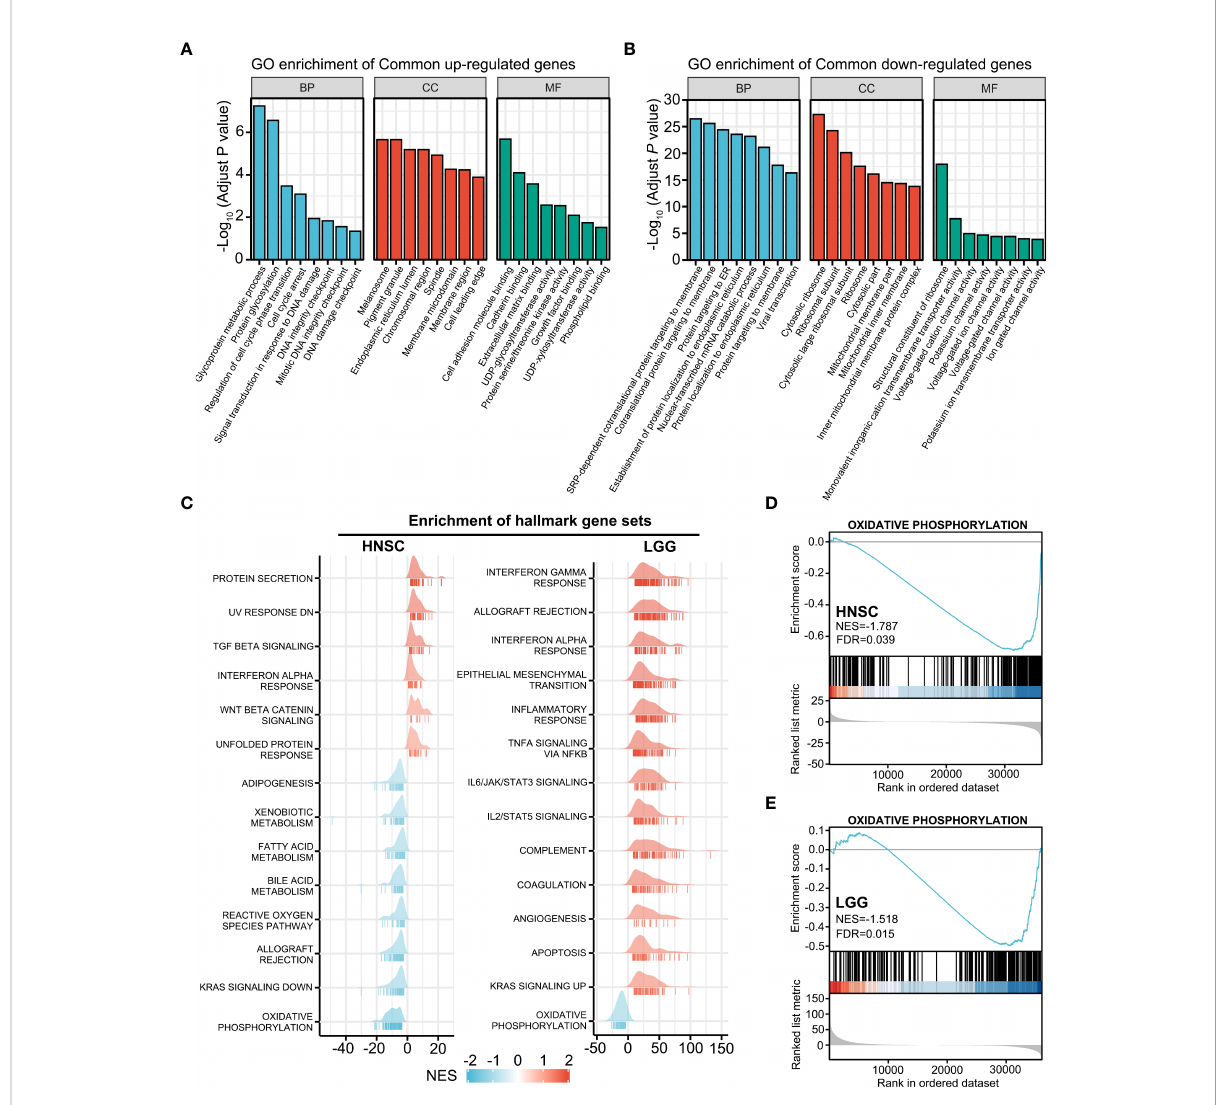
FIGURE 4 HOXA1-associated signaling pathway. (A) GO enrichment analysis of overlapping upregulated genes ( P < 0.05) of the HNSCC and LGG cohorts. (B) GO enrichment analysis of the overlapping downregulated genes ( P < 0.05) of the HNSCC and LGG cohorts. (C) Ridgeline plots depicting the signi fi cantly enriched signaling pathways involving the HOXA1-associated DEGs in HNSCC and LGG as revealed by GSEA performed using 50 hallmark gene sets. (D, E) GSEA plots showing that the oxidative phosphorylation gene set was negatively enriched in HNSCC and LGG samples with high HOXA1